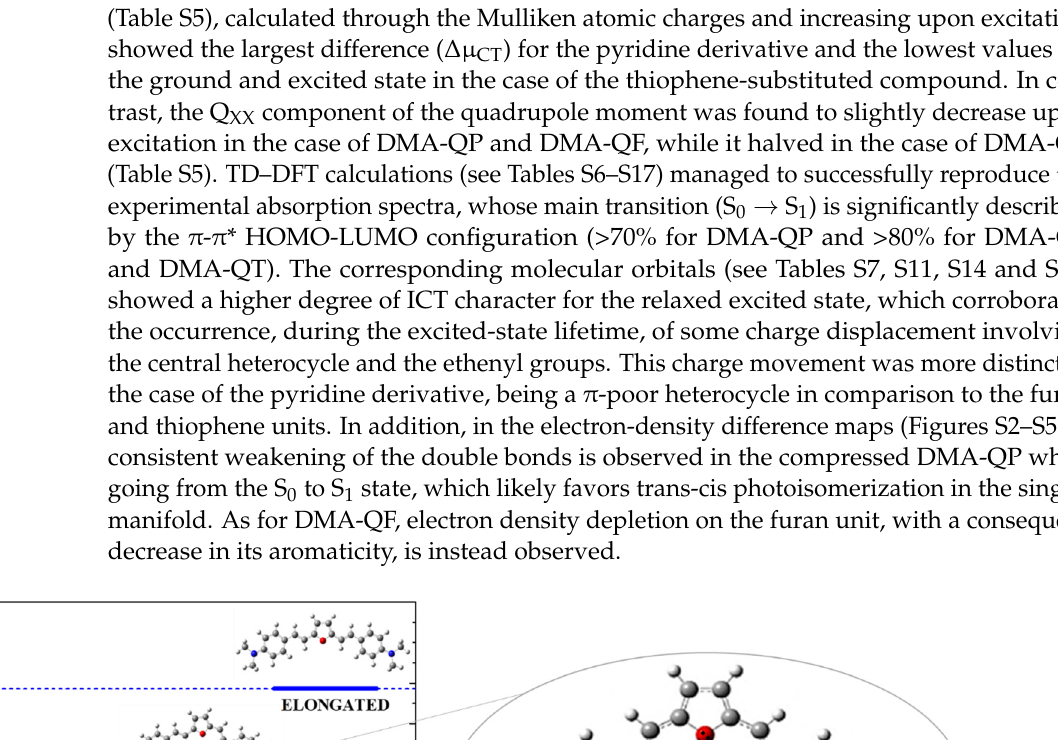
Figure 4. Linear plots of the Stokes shift vs. solvent properties (dielectric constant, ε , and refractive index, n ) of the investigated compounds (DMA-QP ( left ), DMA-QF ( middle ), DMA-QT ( right )).